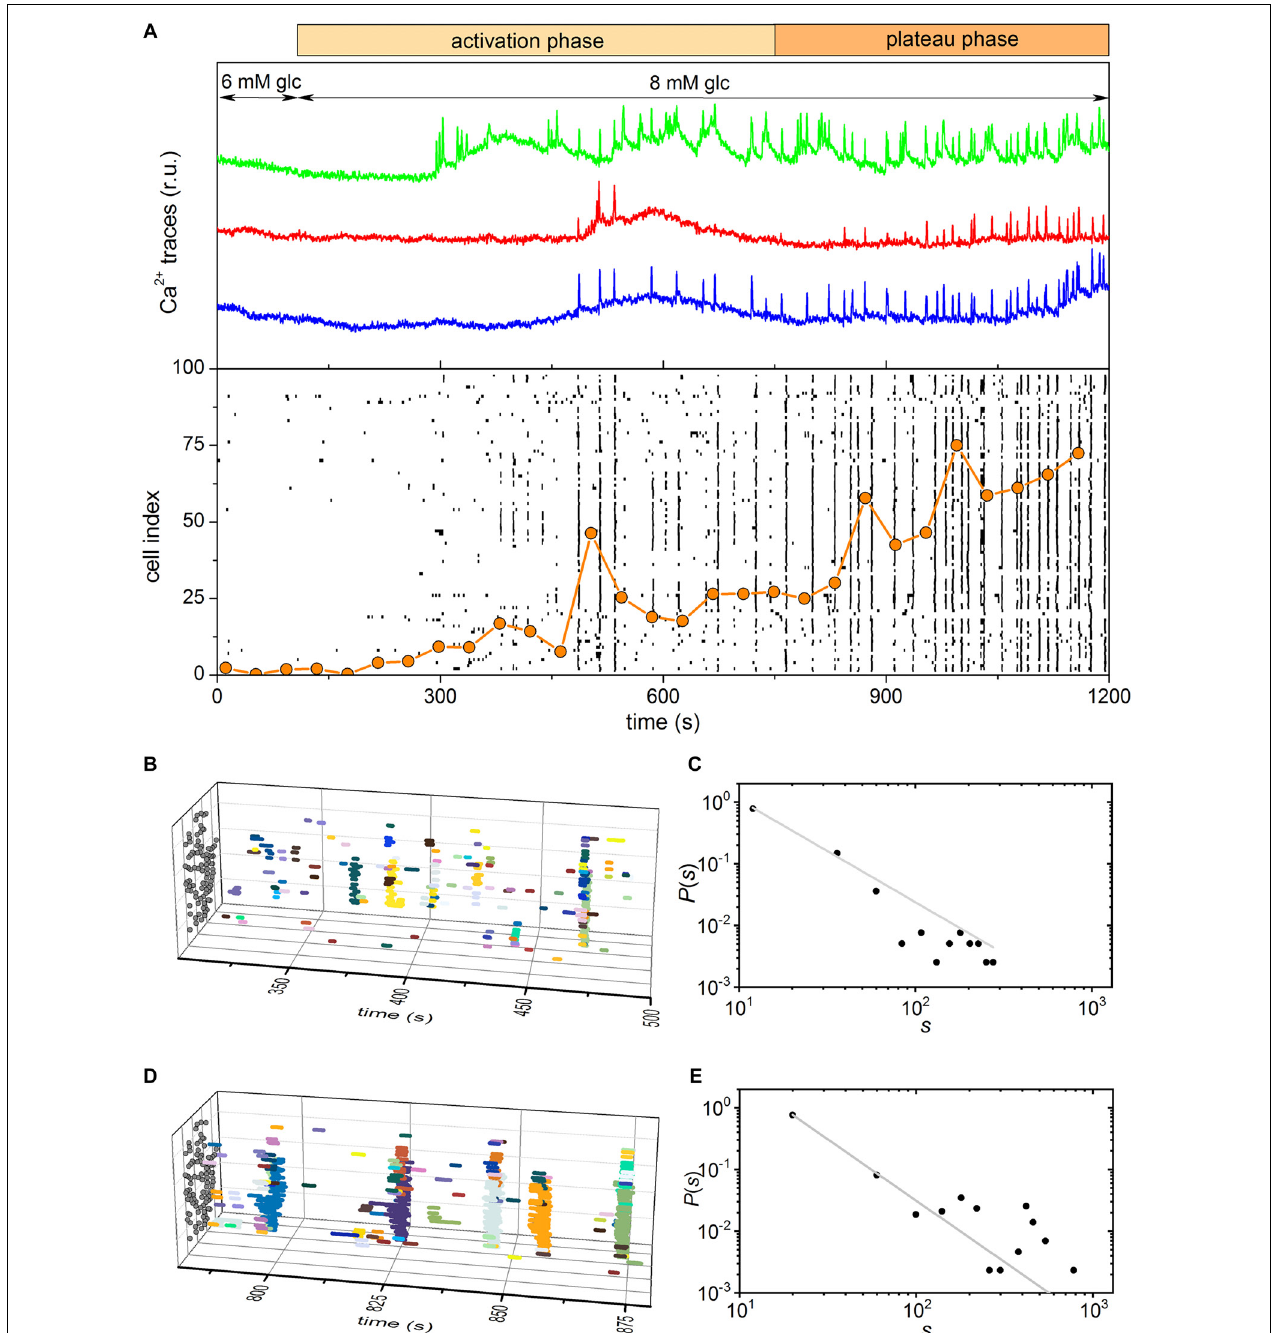
FIGURE 4 | Experimentally measured beta cell responses after stimulation with 8 mM glucose. (A) Three characteristic Ca 2 + traces and the raster plot of binarized Ca 2 + activity of all cells in the islet. The orange dotted line indicates the fraction of active cells within the given time-window that was slid throughout the recording. (B,D) 3D raster plots showing the Ca 2 + activity waveforms for selected intervals for the activation (B) and plateau (D) phase. Colors denote specific Ca 2 + events. Gray dots on the y , z plane stand for coordinates of cells. (C,E) The distributions of Ca 2 + wave sizes for the activation (C) and plateau (E) phase. The gray dashed line indicates the power-law fit. The slope in the critical-like activation phase is